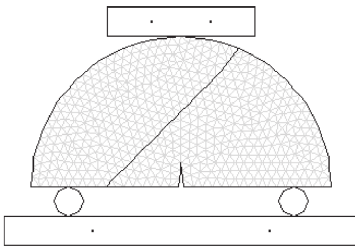
Figure 1: Numerical model of the half-disc specimen.